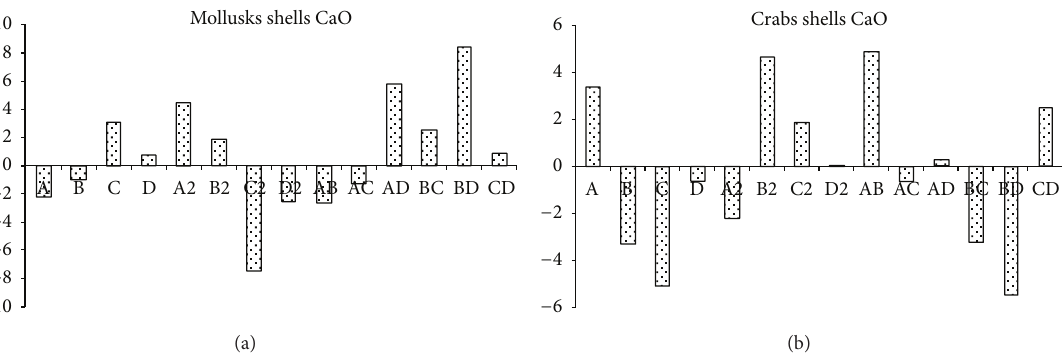
Figure 7: Pareto chart showing the effects of different independent variables on % biodiesel